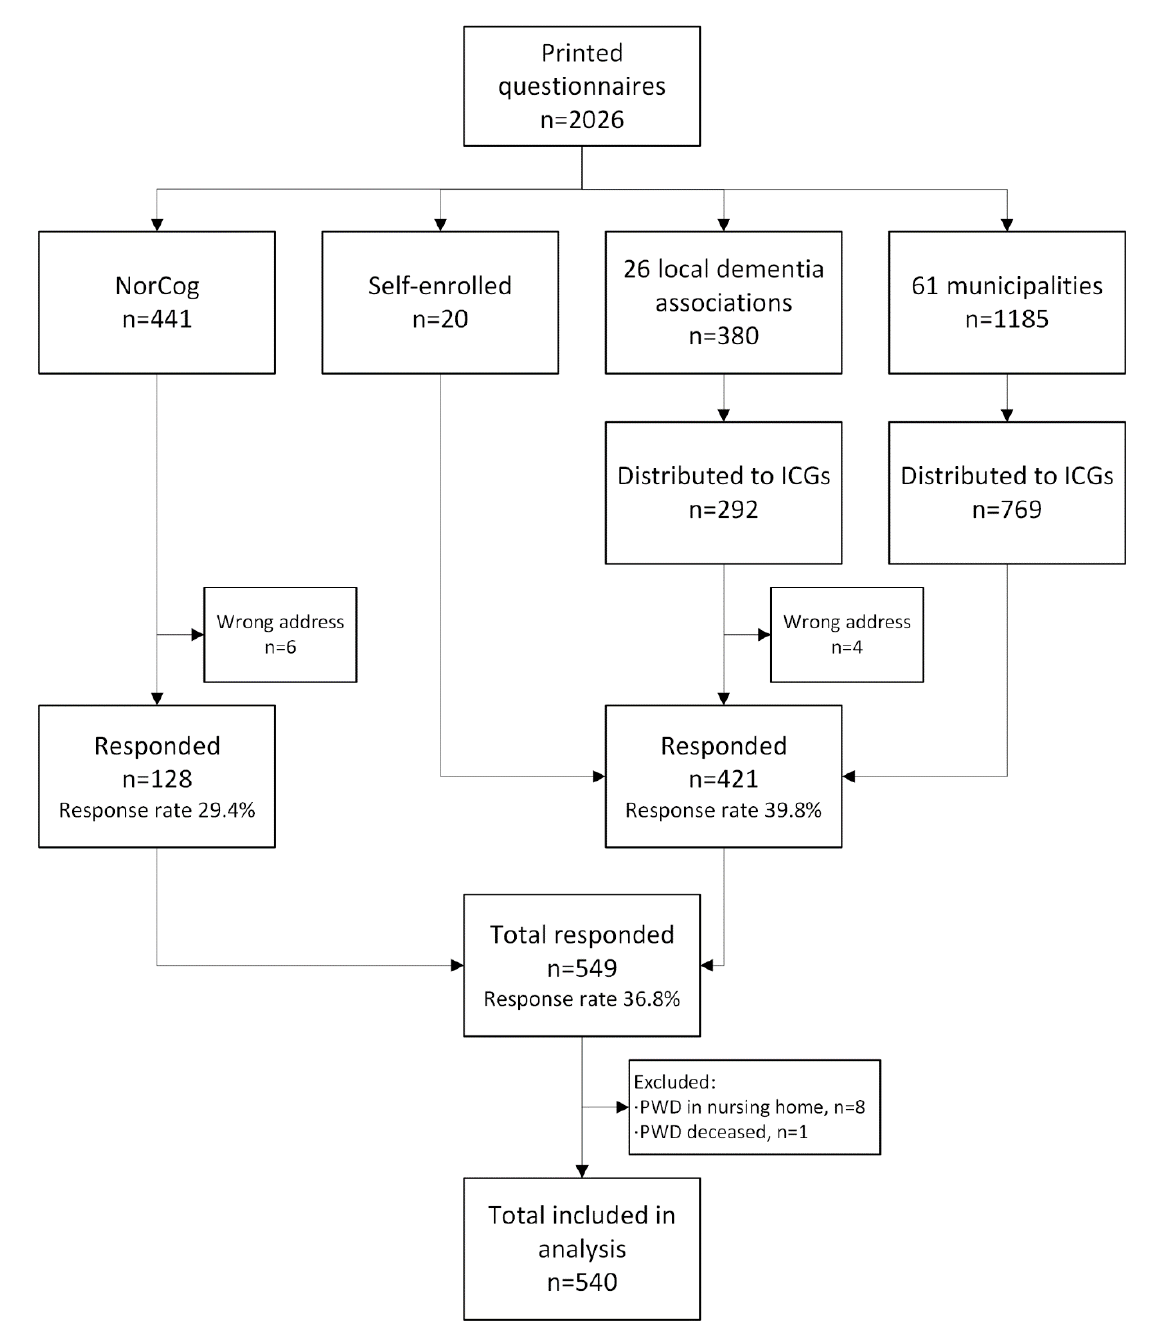
Figure 2. Recruitment. ICG: informal caregiver, PWD: person with dementia, NorCog: the Norwe- gian Registry of Persons Assessed for Cognitive